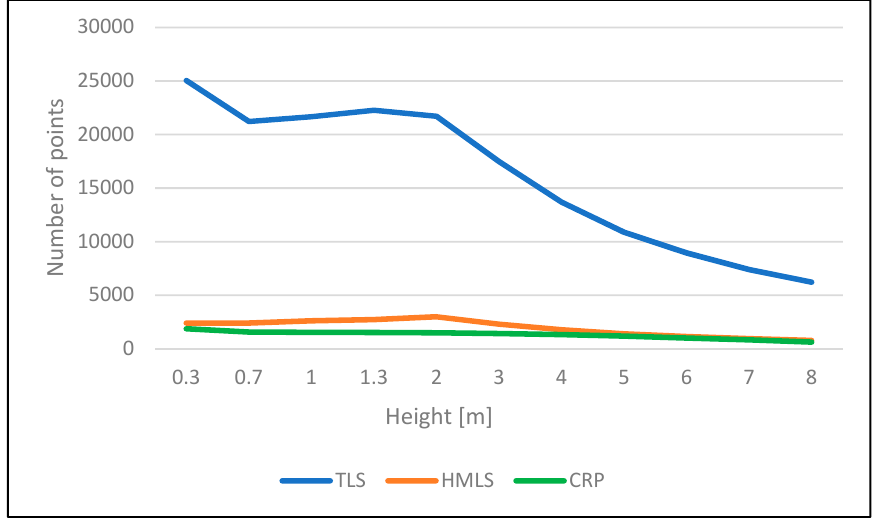
Figure 3. Number of points in the cross sections.